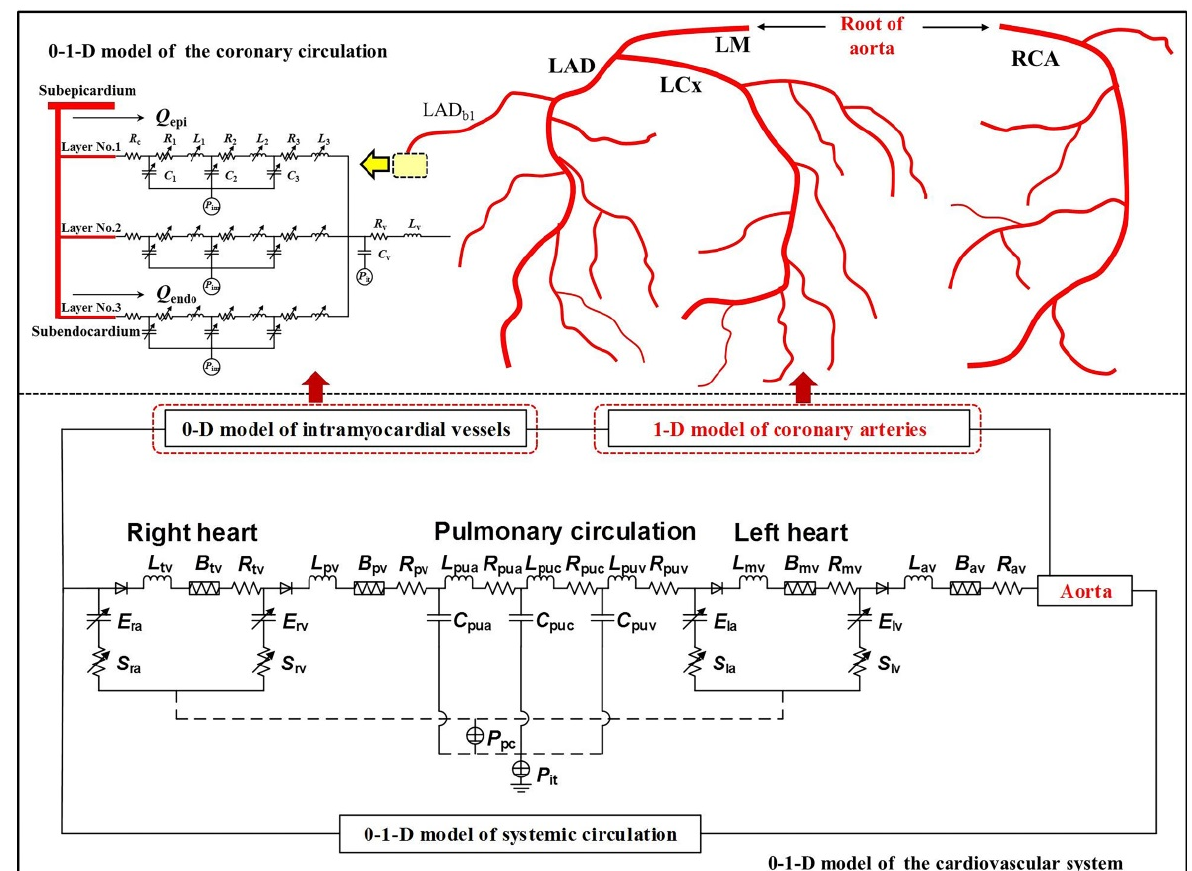
Figure 1. Schematic description of computational modeling of the coronary circulation coupled to the global cardiovascular system. Abbreviations: LM, main trunk of the left coronary artery; LAD, left anterior descending artery; LCx, left circumflex coronary artery; RCA, right coronary artery.